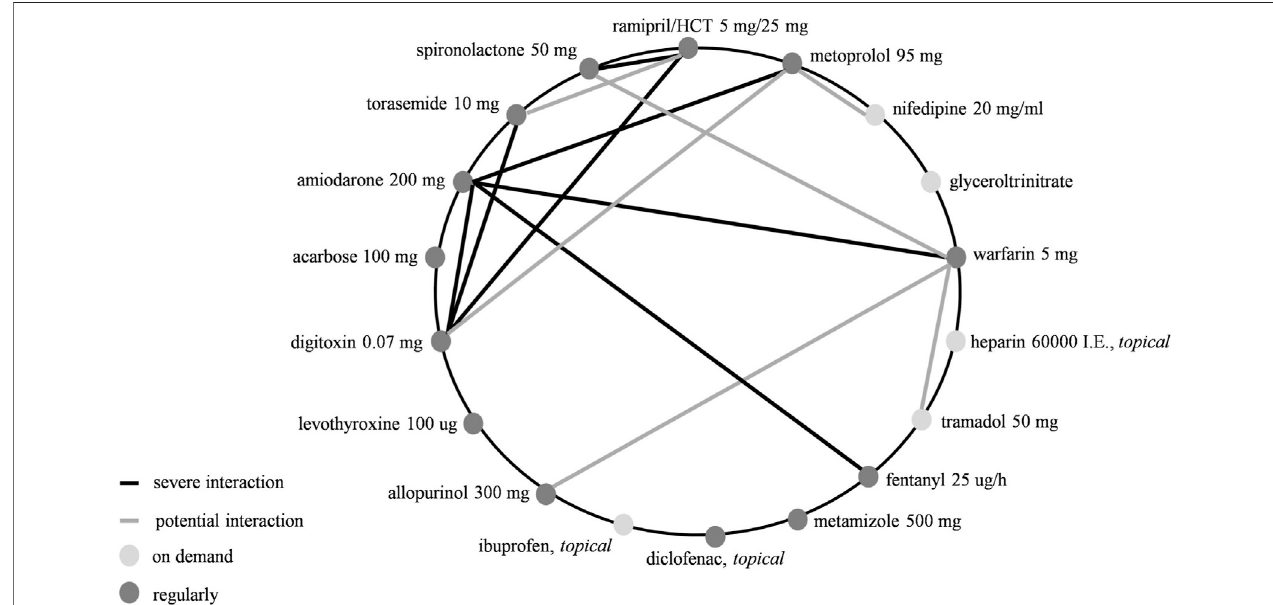
FIGURE 5 | Drug-drug interactions of prescribed medication in one